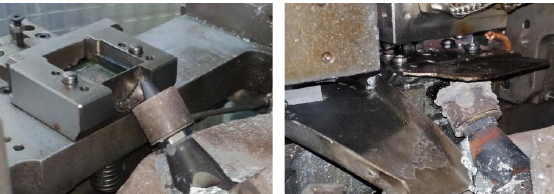
Figure 6. Location of the protection plates of the heating set and the internal parts of the moulding